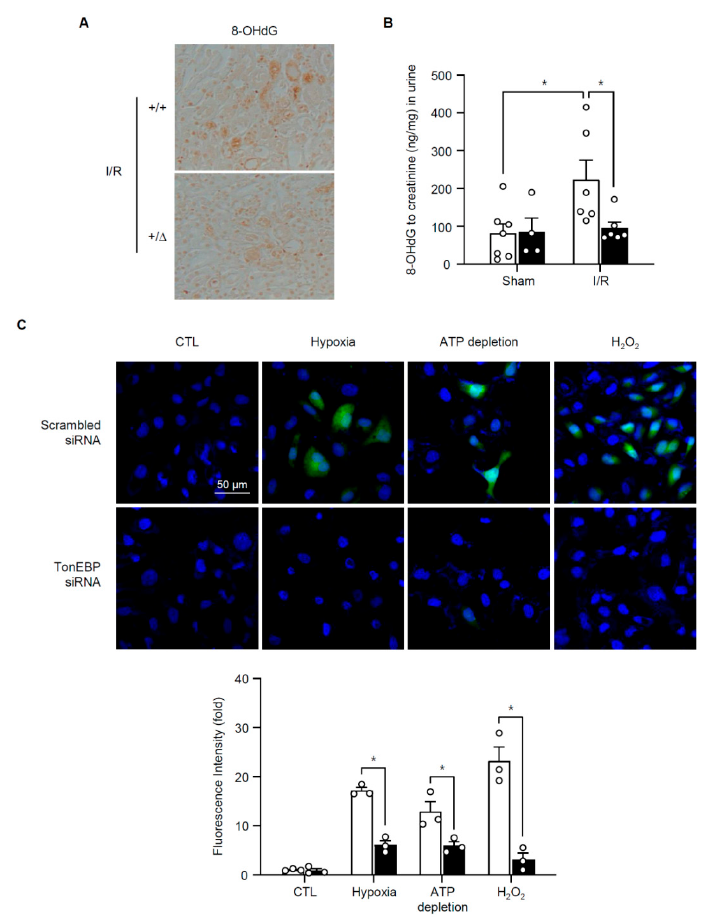
Figure 10. Effects of TonEBP deficiency on oxidative stress in kidneys and HK-2 cells. Renal I/R or sham treatment was performed on TonEBP +/ Δ mice (+/ Δ , filled bars) and their TonEBP +/+ littermates (+/+, open bars). ( A ) Kidney sections were stained for 8-OHdG. 8-OHdG and creatinine were measured from urine samples and their ratios in ng/mg are shown ( B ). ( C ) HK-2 cells were transfected with TonEBP targeted (open bars) or scrambled siRNA (filled bars) followed by no treatment (CTL), or treatment with hypoxia, ATP depletion, or H 2 O 2 . Fluorescent images of DCF (green) and Hoechst 33342 (blue) in HK-2 cells loaded with DCF-DA are shown at the top. DCF fluoresence intensity as Mean ± SEM is shown at the bottom. * p < 0.05.